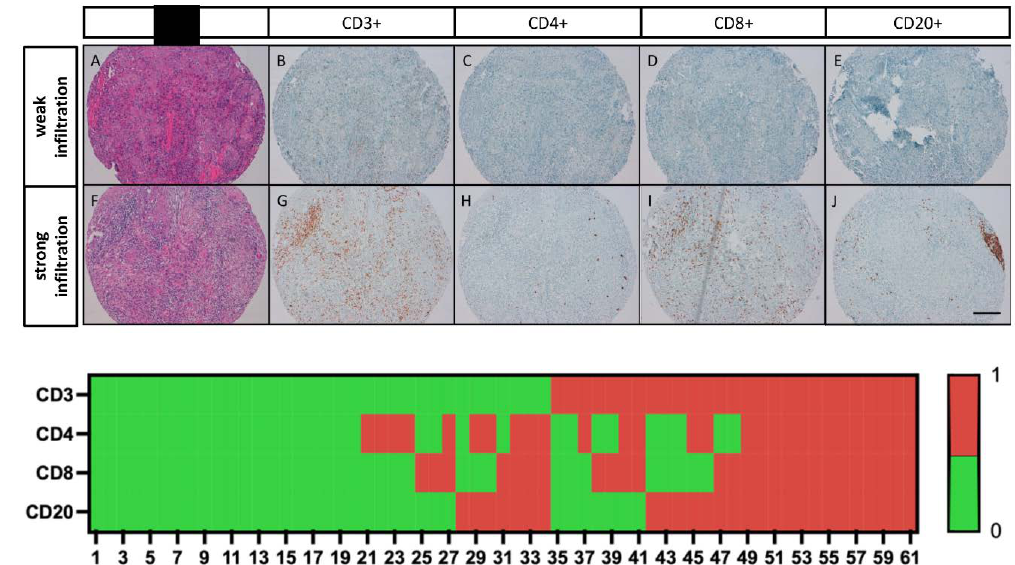
Figure 1. Immunoreactivity of TIL subtypes in bladder SCC and case-related expression patterns of CD3, CD4, CD8 and CD20. A–E representative photomicrographs show the same TMA sample with pure bladder SCC ( A , H , E ) and weak infiltration with CD3+ ( B ); CD4+ ( C ); CD8+ ( D ); and CD20+ TILs ( E ). ( F – J ) representative photomicrographs show the same TMA sample with pure bladder SCC ( F , H , E ) and strong infiltration with CD3+ ( G ); CD4+ ( H ); CD8+ ( I ); and CD20+ TILs ( J ). Scale bar = 100 µ